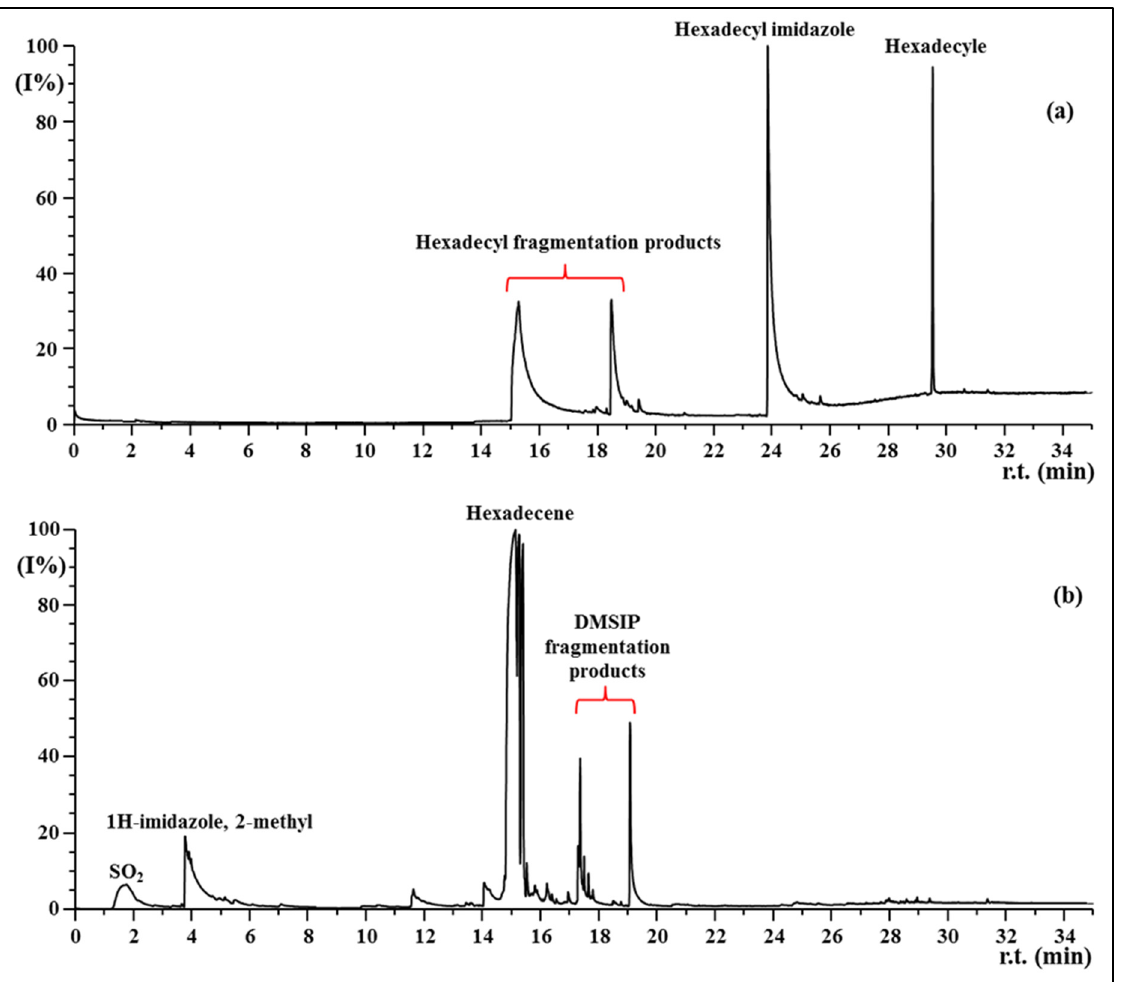
Figure 8. Py-GC/MS pyrograms of the thermal products of the IL HdmimDMSIP recorded at ( a ) 300 ◦ C and ( b ) 450 ◦